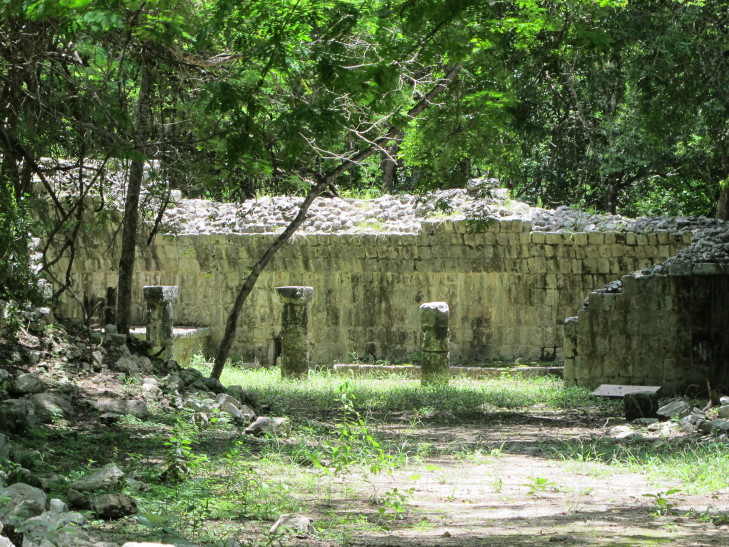
Brachypelma
epicureanum habitat with archaeological ruins, Mexico. Photo: Jorge Mendoza.